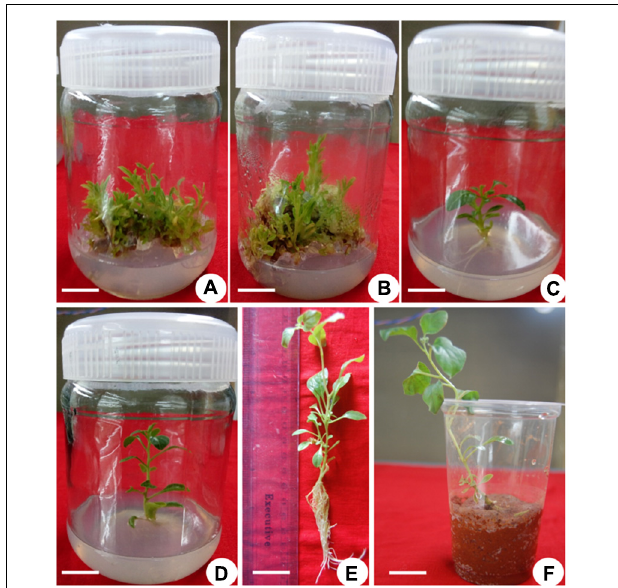
FIGURE 2 | Multiple shoot induction in Withania somnifera . (A) Induction of multiple shoots from nodal explant with 6-benzylaminopurine (BAP) and Kinetin (KIN) (scale bar = 0.5–1.3 cm), (B) multiplication of shoots with BAP and TDZ (scale bar = 1.00–3.05 cm), (C) elongation of shoots using BAP and KIN (scale bar = 2–5.3 cm), (D) induction of roots from elongated shoots [indole-3-butyric acid (IBA) 0.3 mg/L] (scale bar = 6.5 cm), (E) well-developed plantlets (scale bar = 18 cm), and (F) hardening of plantlets at 25 ± 2 ◦